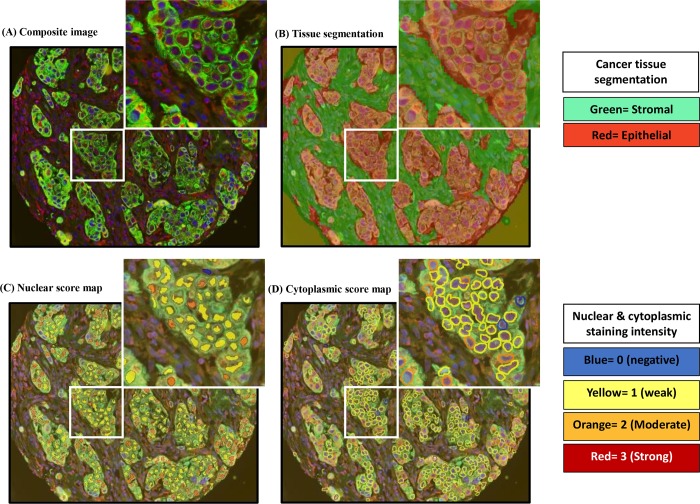
Dual IF staining for BRCA1 and CK8/18 and corresponding digital annotation for BRCA1 in a representative core.A: Composite image where green fluorescent staining if for epithelial CK8/18, red is for BRCA1, and blue is for nuclear DAPI stain. B: Tissue segmentation. C: Nuclear score map. D: Cytoplasmic score map. The attached legend to the right indicates what each color stands for in the tissue segmentation and score maps.